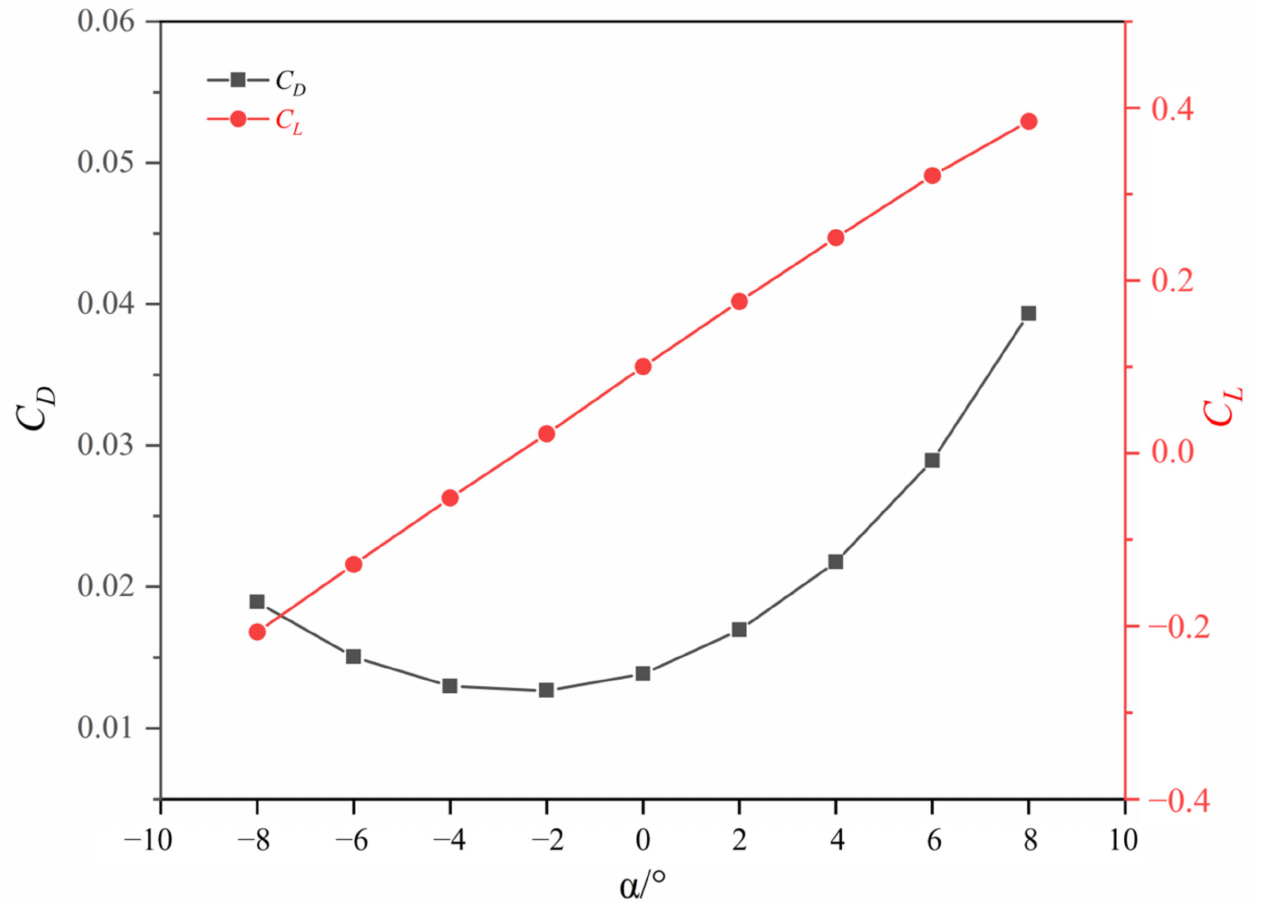
Figure 7. Variation of a single manta ray gliding: resistance coefficient and lift coefficient with angle of